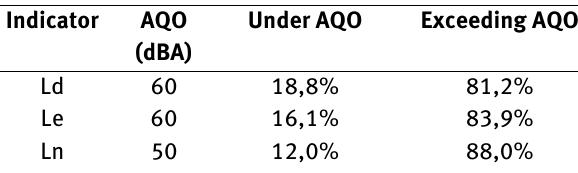
Table 1: PTS study area environmental noise diagnosis from